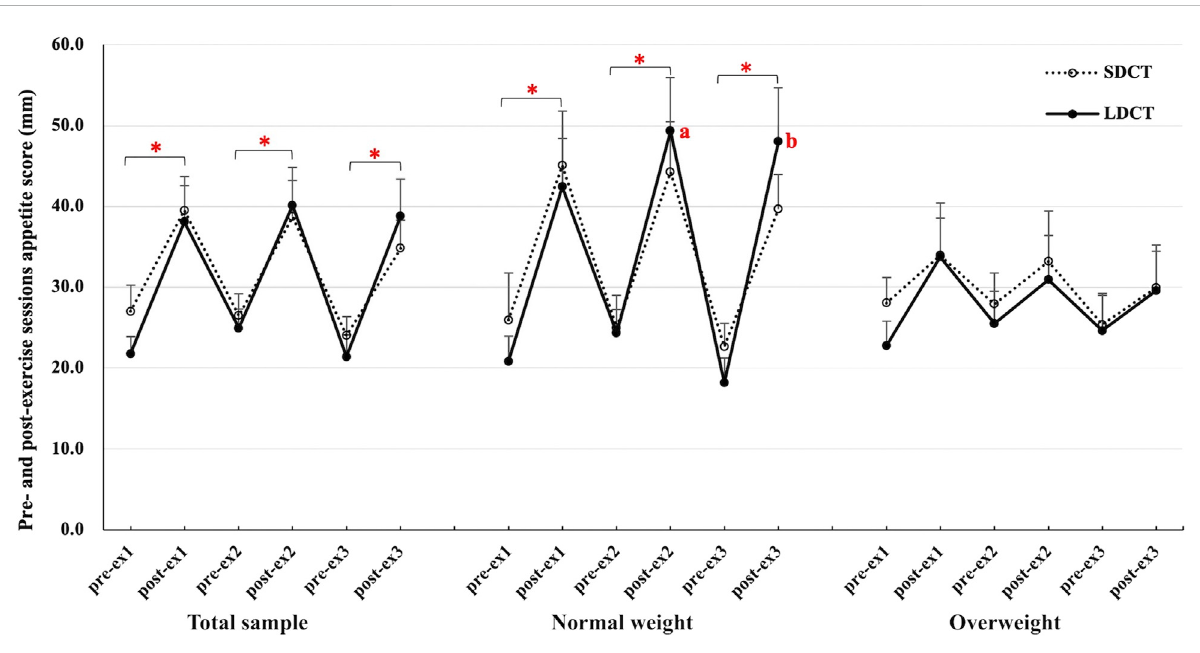
FIGURE 5 Pre- and post-exercise sessions appetite score in the total sample, normal and overweight adults. Data are expressed as the mean ± SEM. *Signi fi cantdifference, p < 0.05. ab Signi fi cantlydifferentfromLDCTintheoverweightgroup, p <